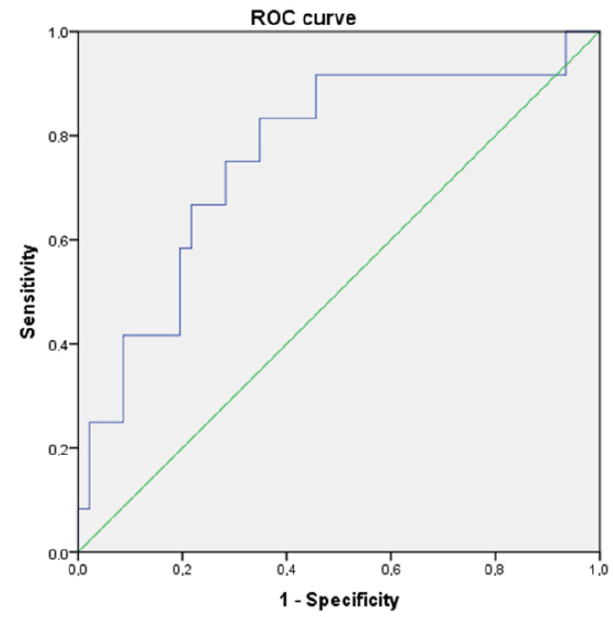
Figure 1. E2/T ROC (Receiver Operating Characteristic) curve for ED. AUC (Area Under Curve) = 0.763.